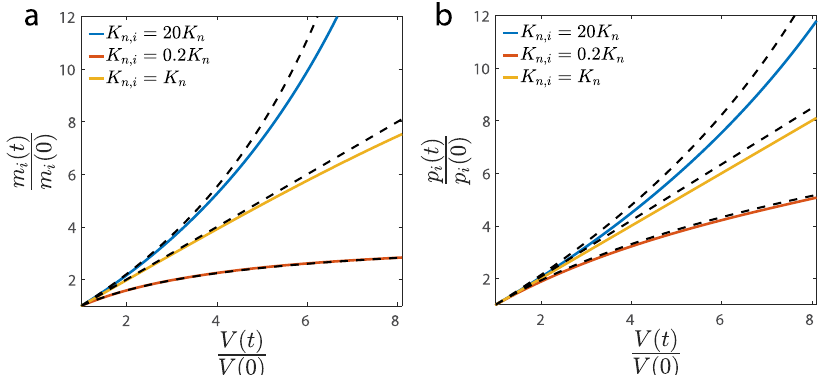
Fig. 2 We simulate the model with two special genes and their Michaelis-Menten constants are respectively K n , i = 20 K n , K n , i = 0.2 K n . All the other genes have K n , i = K n . ( a ) The mRNA levels of the two special genes show superlinear and sublinear scalings with cell volume, in agreement with the theoretical predictions (dashed lines). The mRNA numbers and cell volume are normalized by their initial values. b Same analysis as ( a ) for nondegradable proteins. Deviations are expected since the actual mRNA lifetimes are fi nite.